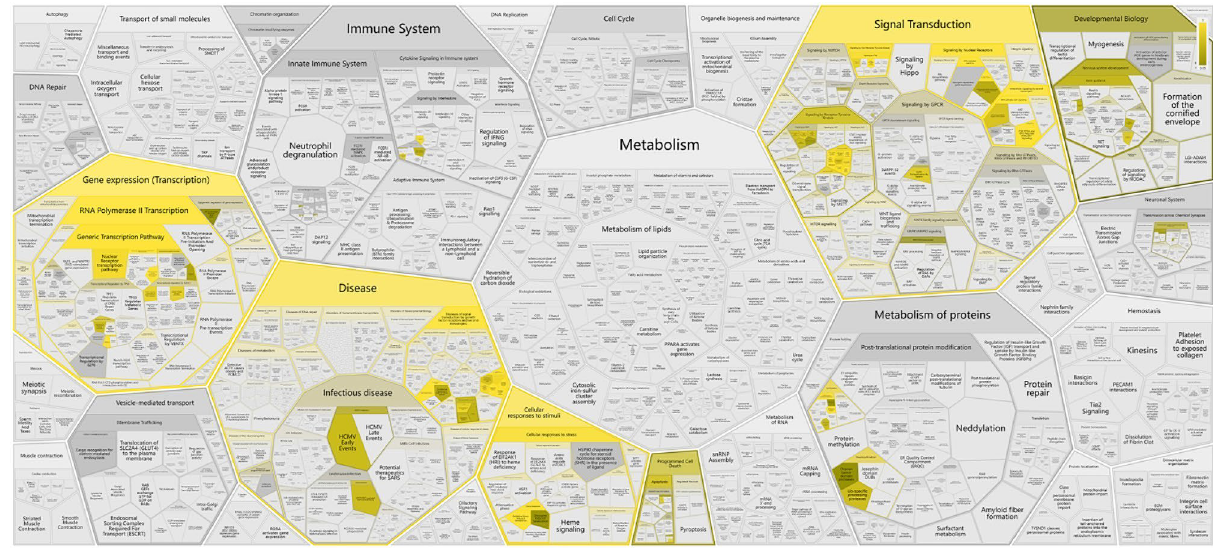
Figure 9. Rectome analysis. The diagrams show the human systems and locations of cellular responses involved in the core targets’ actions, etc. The eight core targets focus on the immune system, the innate immune system, cytokine signaling in the immune system, signaling in the GPCR, vesicle-mediated transport, and other signaling pathways. Among these, the mechanisms involved in the immune system make it a priority for us to understand and study in depth.